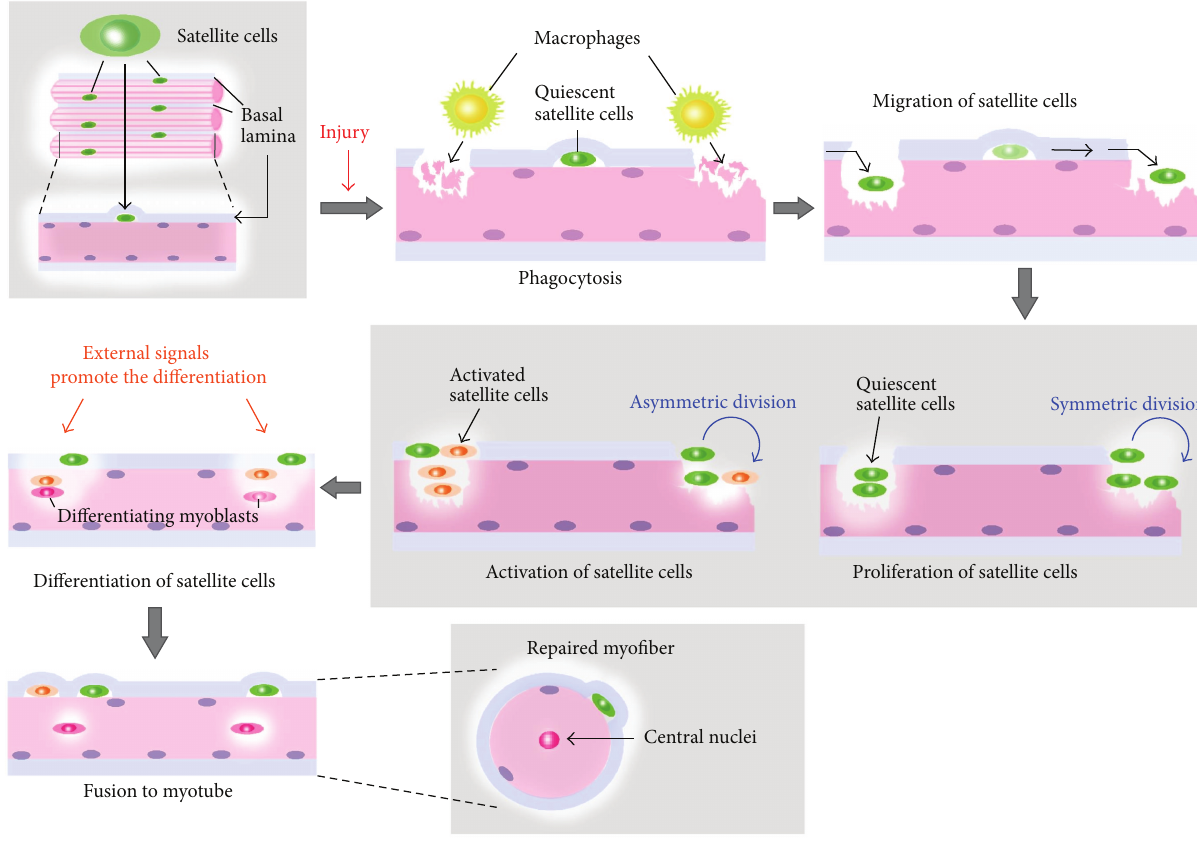
Figure 3: Satellite cell-mediated muscle regeneration upon injury. Damaged muscle fiber induces activation of quiescent satellite cells that reside between the plasma membrane and basal lamina. Macrophages digest myofiber debris at the damaged site (phagocytosis). Satellite cells migrate and proliferate through symmetric and asymmetric divisions. During the process, various external signals promote the differentiation of satellite cells and their fusions to